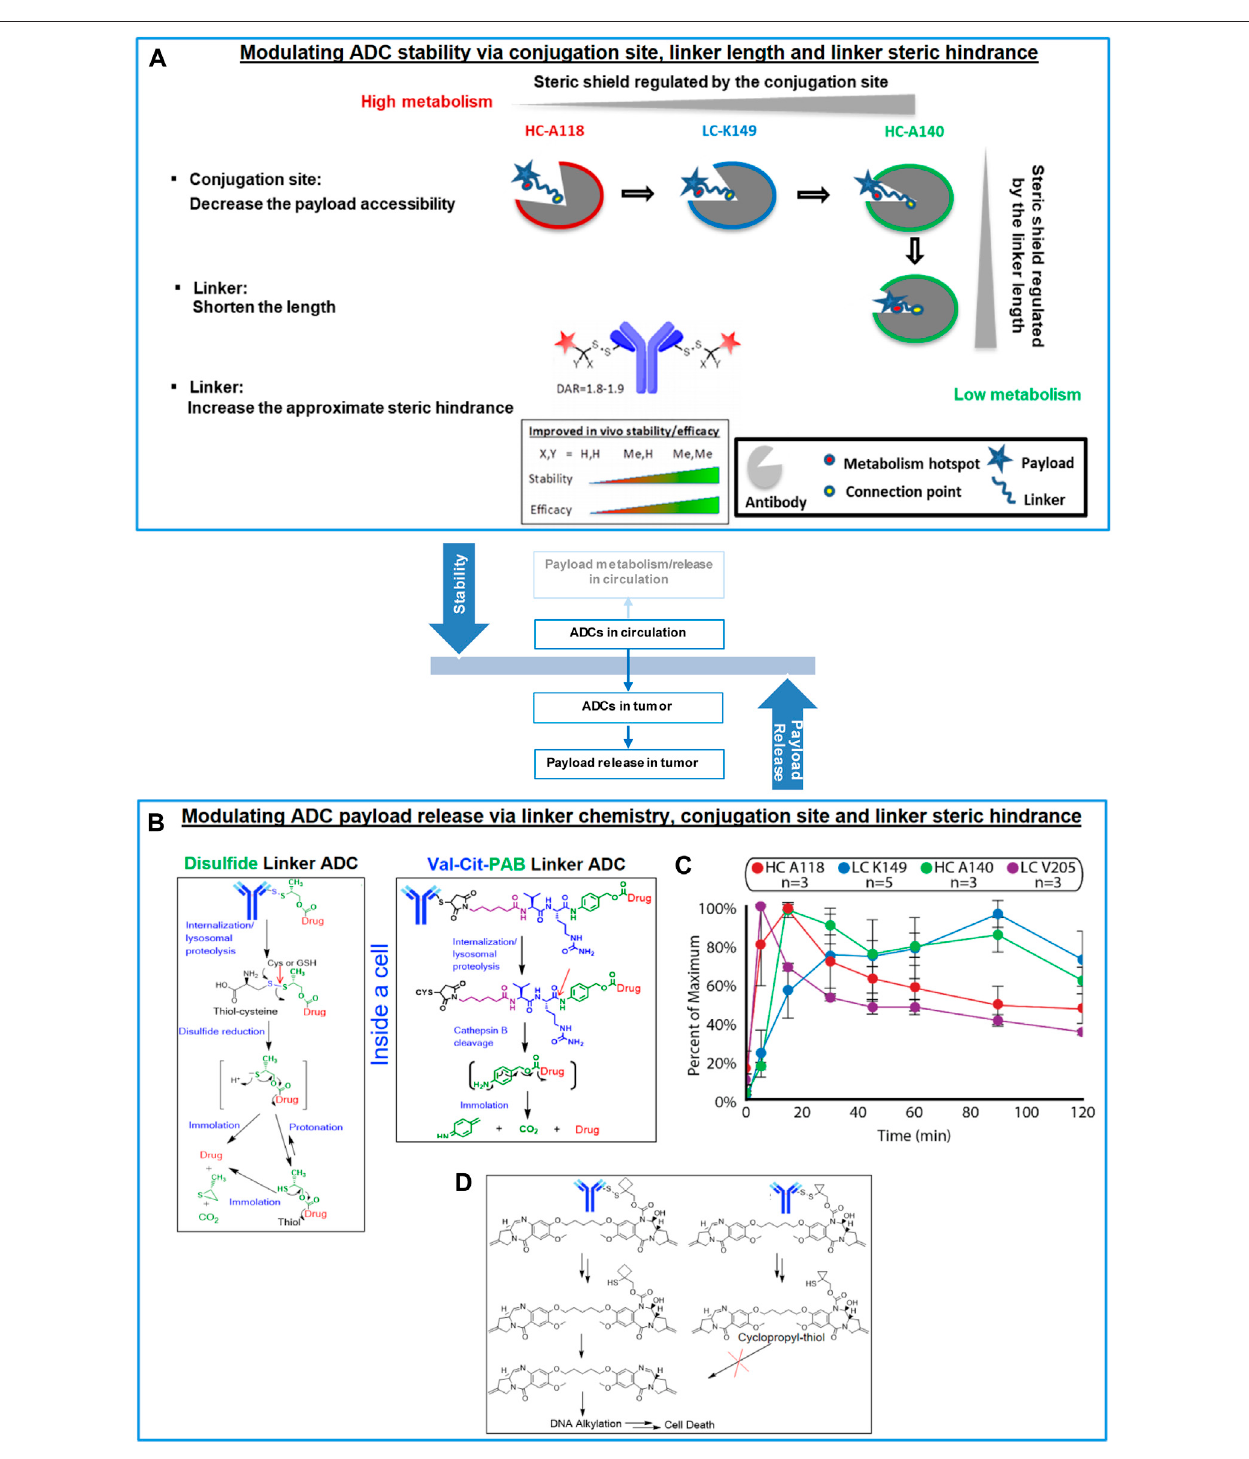
FIGURE 1 | Balancing ADC stability and payload release via linker design and conjugation site. (A) Modulating ADC stability via conjugation site, linker length and proximalsterichindrance(increasedADCstabilitybydecreasingthepayloadaccessibility,shorteningthelinkerlengthandincreasingtheproximalsterichindranceofthe linker), (B) Mechanisms of linker cleavage and immolation, (C) Payload release kinetics in the antibody-conjugated drug assays in fl uenced by conjugation sites ( n (cid:1) 3 – 5 antibodies per conjugation site). Reprinted with permission from (Lee et al., 2020). Copyright (2020) American Chemical Society. (D) Comparison of immolation pathways of aCD22-PBD TDCs with cyclobutyl- and cyclopropyl-disul fi de linker.